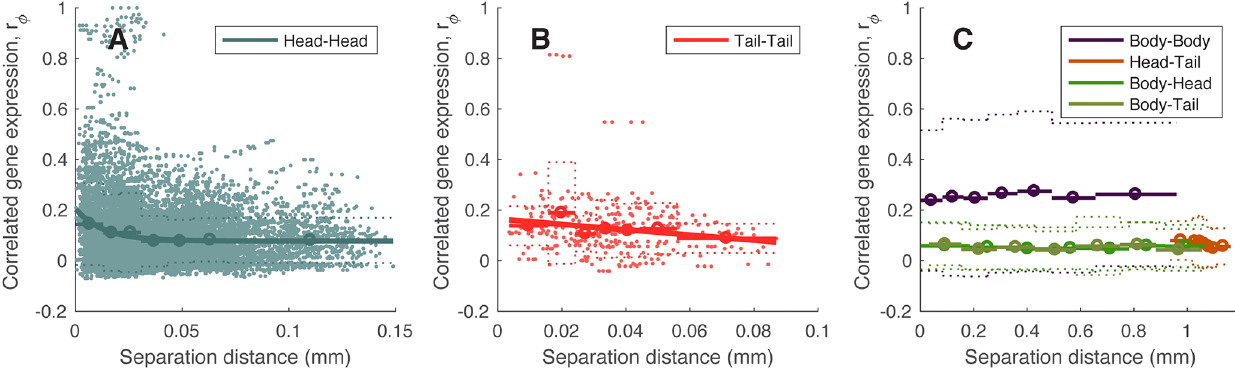
Fig 4. Dependence of correlated gene expression, r , on spatial separation between pairs of neurons. Correlated gene expression, r (excluding bilateral ϕ ϕ homologous pairs of neurons), is shown as a function of the pairwise separation distance between pairs of neurons (shown as the mean (solid) ± standard deviation (dotted) in seven equiprobable distance bins, with extent shown as horizontal bars), for (A) all pairs of neurons in the head, (B) all pairs of neurons in the tail, and (C) all other pairs (labeled). Scatters for all neuron pairs are added in (A) and (B). An exponential relationship, f ( x ) = A exp( − λ x )+ B , is fitted in (A) and (B). The weak decreasing trend in r ϕ with distance, is primarily driven by a small subset of nearby neurons with high r ϕ , and may therefore represent a more specific relationship between particular neurons, rather than a general, bulk spatial relationship observed in macroscopic mammalian brains [38,